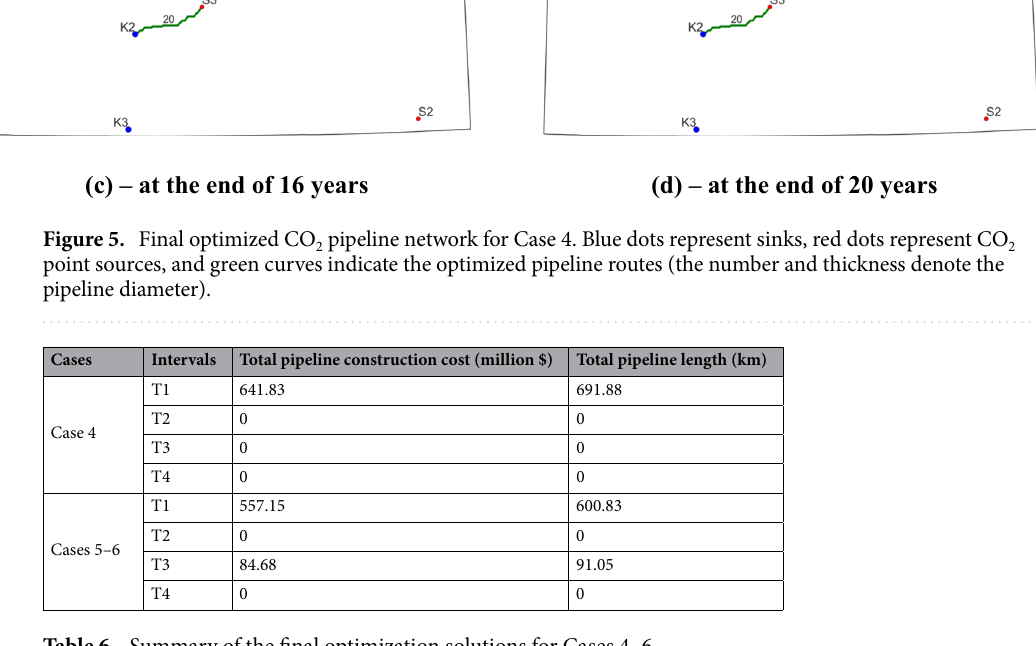
Table 6. Summary of the final optimization solutions for Cases